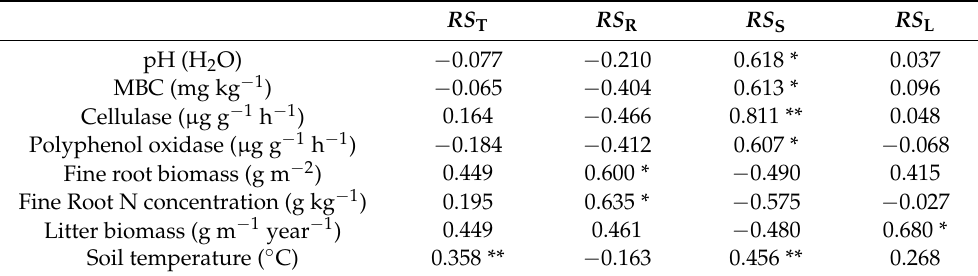
Table 4. The correlation coefficients between soil respiration rates and soil temperature, soil chemical properties, fine root biomass and microbial characteristics in the Pinus tabulaeformis